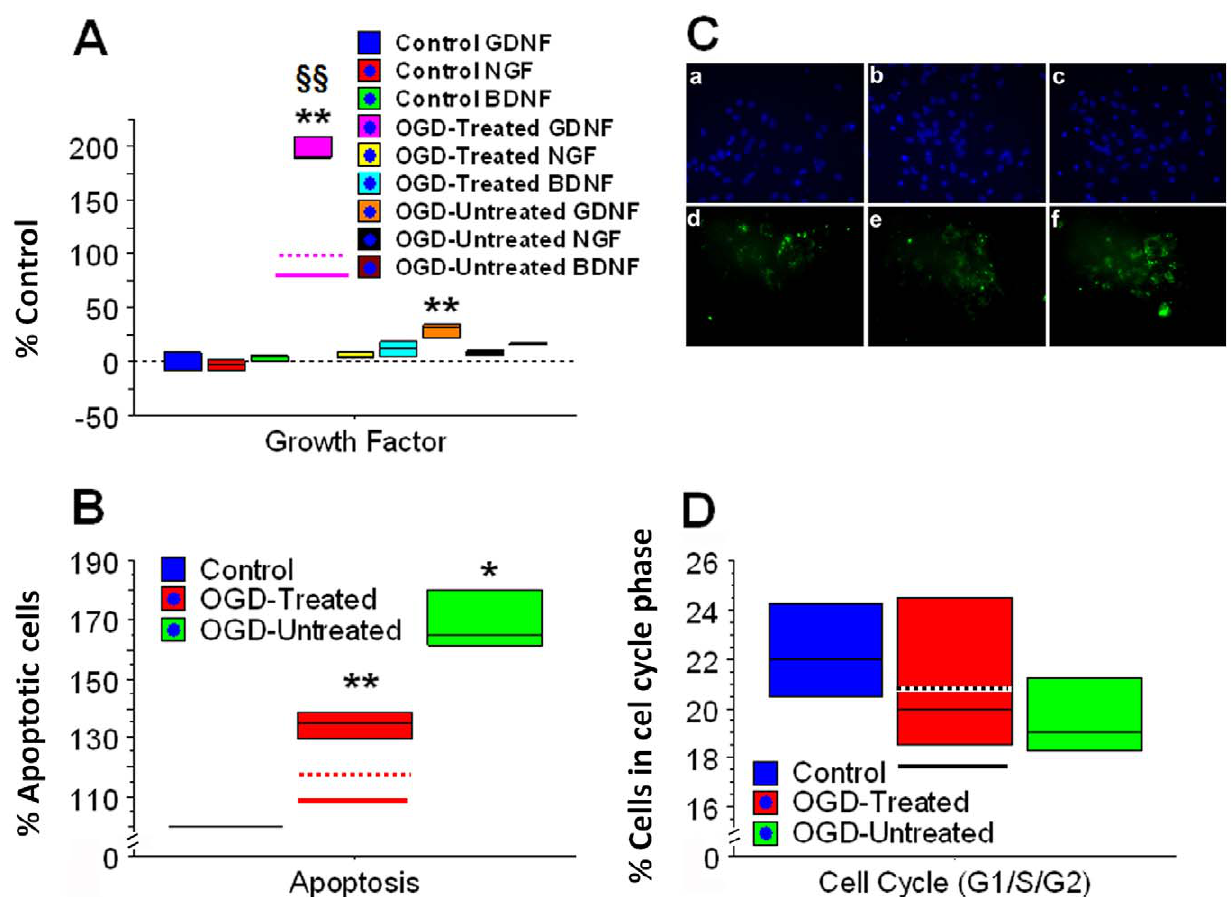
Figure 5. Non-opioid neuroprotective mechanisms accompanying combination therapy of moderate hypothermia, MSCs and DADLE. Results revealed significant upregulation of GDNF, but not NGF or BDNF after combination therapy with or without DADLE (OGD-Treated) compared to OGD-Untreated and Control (Panel A). GDNF was also upregulated slightly in OGD-Untreated condition, likely due to an endogenous compensatory mechanism of the PRNCs. Similarly, OGD-Treated significantly reduced apoptosis compared to Control and OGD-Untreated. Apoptosis via ApoAlert assay is quantified (Panel B) and representative images shown (Panel C) (a-c are Hoechst-stained PRNCs, whereas d-f are corresponding apoptotic stained cells; a/d: Control; b/e: OGD-Treated; c/f: OGD-Untreated). There were no significant differences in cell cycle condition across the three conditions (Panel D). Symbols represent **p , 0.0005 vs. Control GDNF; *p , 0.0005 vs. Control GDNF; 11 p , 0.0001 vs. OGD-Treated GDNF (Panel A); **p , 0.0001 vs. control; *p , 0.005 vs. control and untreated (Panel B). Dashed lines in Panels A, B and D (pink, red, and black, respectively) indicate combined treatment of moderate hypothermia and MSCs without DADLE. Solid lines in Panels A, B and D (pink, red, and black, respectively) indicate treatment with antibody against GDNF and combined treatment of moderate hypothermia and MSCs without DADLE.